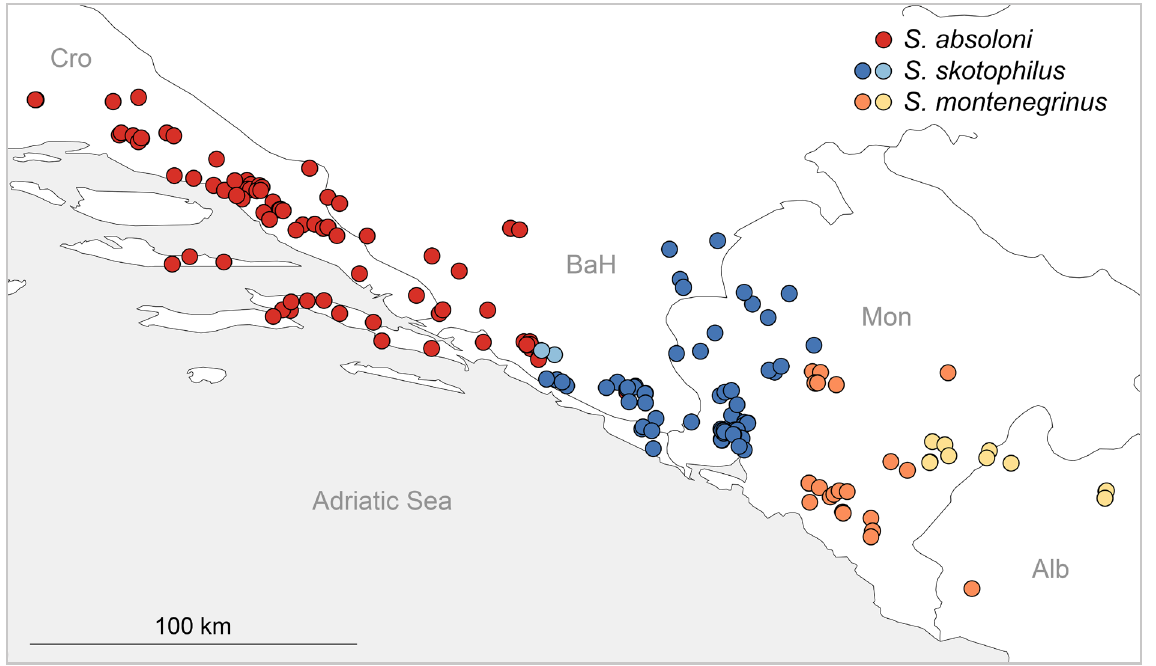
Fig. 168. Known distribution of the ‘northern clade’ of Stygopholcus Kratochvíl, 1932. Pale blue and pale orange marks denote specimens that are assigned tentatively to the respective species. Abbreviations: Alb = Albania; BaH = Bosnia and Herzegovina; Cro = Croatia; Mon =